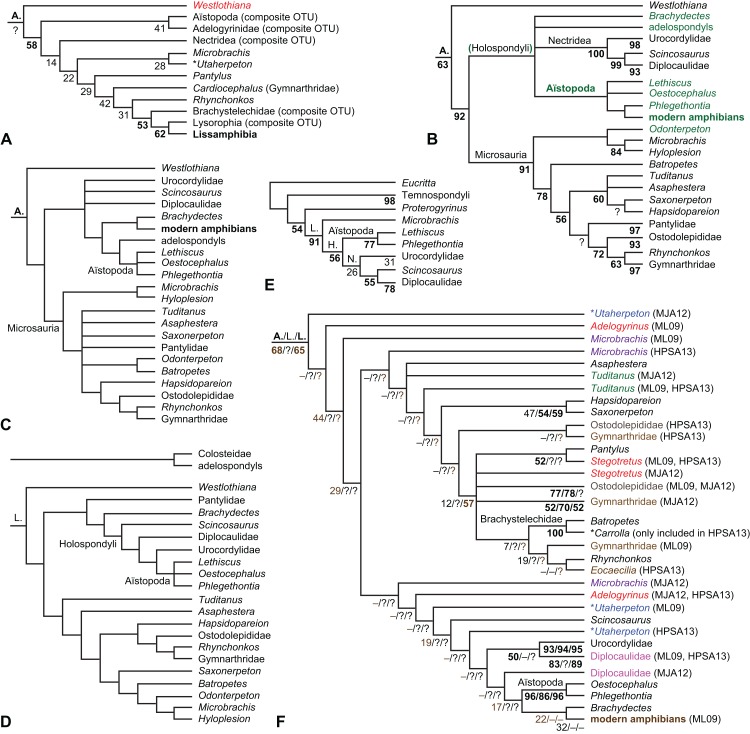
Hypotheses on “lepospondyl” relationships since 2004.Various named clades are collapsed. Taxa not included in our analyses are omitted; those included in the expanded but not the original taxon sample are marked with an asterisk. A., Amphibia; HPSA13, Huttenlocker et al. (2013); L., Lepospondyli; MJA12, Maddin, Jenkins & Anderson (2012); ML09, Marjanović & Laurin (2009). (A) Vallin & Laurin (2004). The other position of Westlothiana lies outside Amphibia and is not shown (see Fig. 27A). Numbers are published bootstrap percentages. (B) Pawley (2006: fig. 88). Numbers are bootstrap percentages from fig. 63 (those below 50 were not reported), which shows an analysis that omitted the taxa written in dark green but found a congruent topology. (C) Pawley (2006: fig. 91): cranial characters and data as in (B), but the postcranial ones unchanged from Ruta, Coates & Quicke (2003). (D) RC07. (E) Milner & Ruta (2009); entire tree except the aïstopod **Ophiderpeton. Adelospondyls and lysorophians were not included. H., Holospondyli; N., Nectridea. Numbers are published bootstrap percentages. (F) Matrices derived from that of Anderson et al. (2008a), namely: (1) ML09; (2) MJA12 as reanalyzed by Marjanović & Laurin (2018), lacking the corrections proposed by ML09 and those by Sigurdsen & Green (2011) but containing those by Maddin & Anderson (2012) and new ones by MJA12; (3) HPSA13, lacking all of the proposed corrections mentioned here but containing new ones. Note that ML09 found the LH, MJA12 the TH and HPSA13 the PH, and that ML09 and HPSA13 did not find Eocaecilia in the same position. Numbers are bootstrap percentages from ML09, MJA12 and HPSA13 in this order (the latter two did not report percentages below 50). Pardo, Small & Huttenlocker (2017: fig. S6) analyzed an unpublished matrix based on MJA12 with some updates based on HPSA13; the MPTs and the Bayesian tree are almost fully congruent with (F), especially with MJA12, but neither bootstrap values nor posterior probabilities were published.